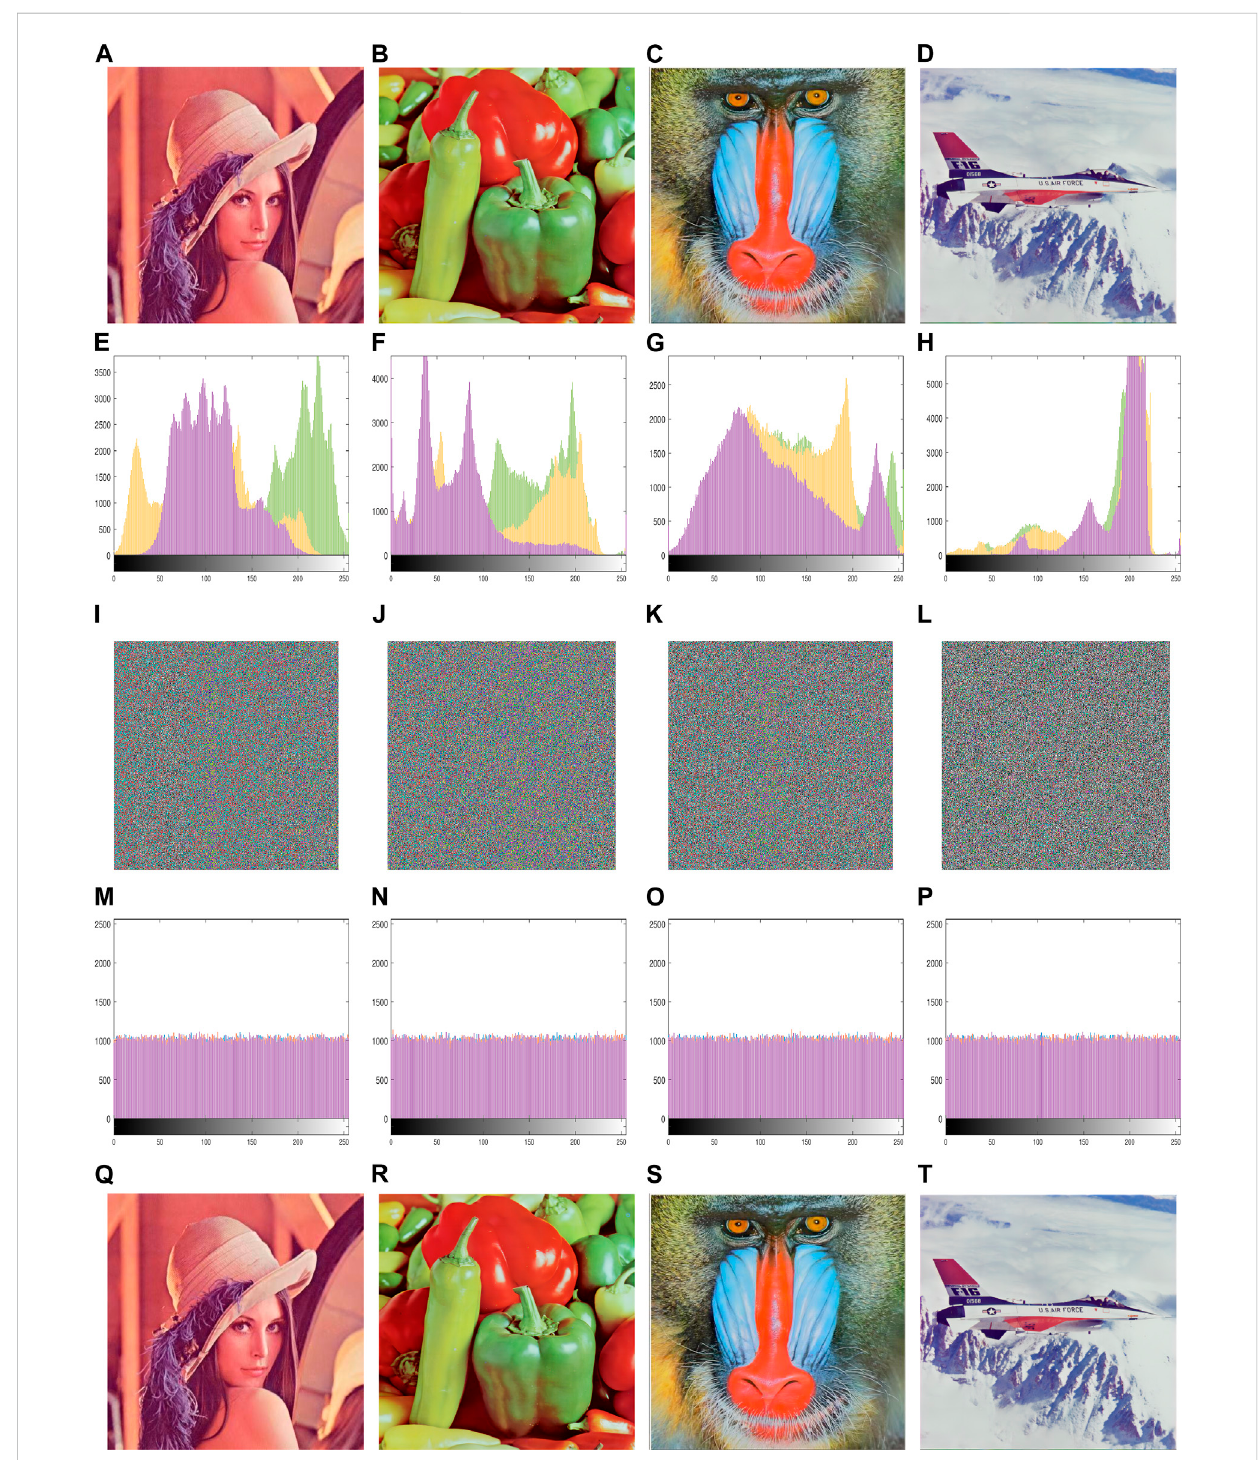
FIGURE 4 Simulation result: (A – D) plaintext images, (E – H) histograms of the plaintext images, (I – L) ciphertext images, (M – P) histograms of the ciphertext images, and (Q – T) decrypted images of ciphertext